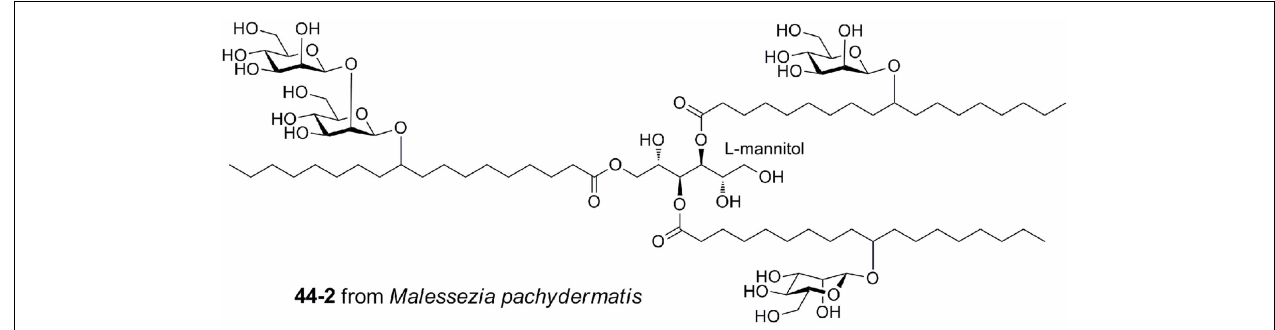
FIGURE 7 | Mannosyloxylstearyl mannitol glycolipid from Malessezia pachydermatis , a ligand for mouse Mincle